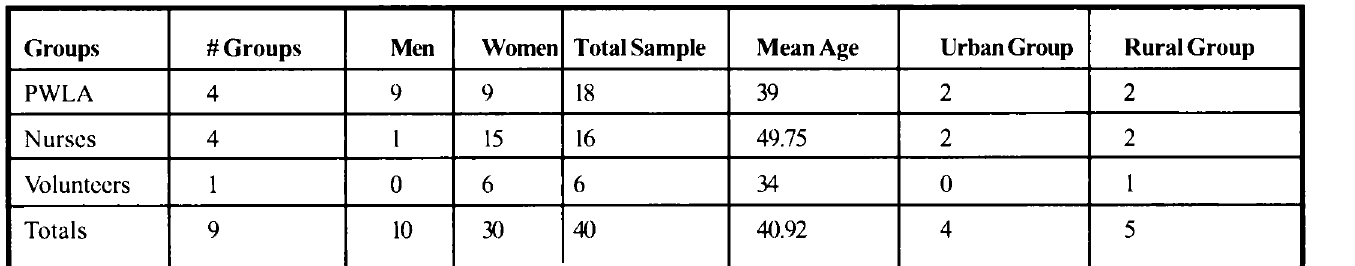
Table 1: Respondents by Groups, Gender and Age